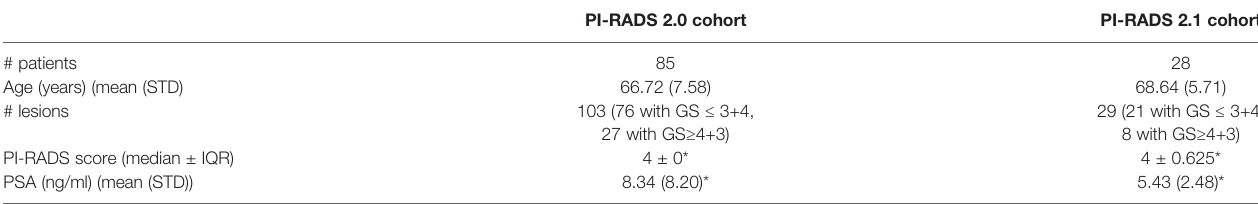
*Indicates signi fi cant differences (p-value < 0.5 at Mann-Whitney test) between PI-RADS 2.0 and PI-RADS 2.1 cohorts. GS, Gleason score; IQR, interquartile range; ISUP GG, ISUP/WHO Grading Group; PI-RADS, Prostate Imaging – Reporting and Data System; PSA, Prostate-Speci fi c Antigen, STD, standard